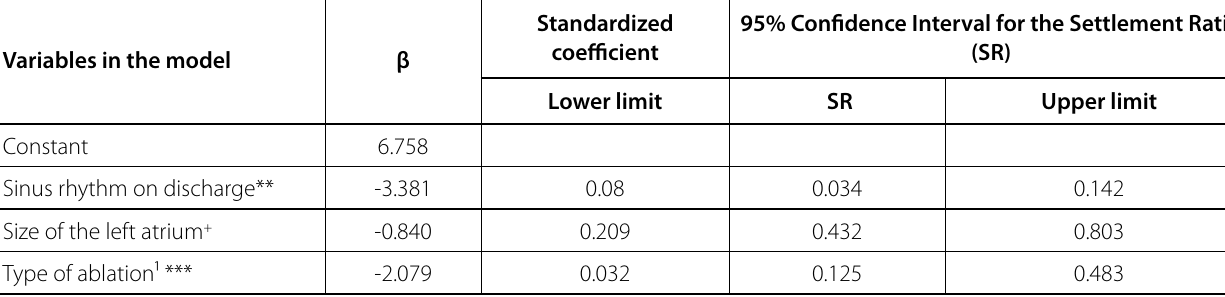
Table 3. Multivariate analysis for sinus rhythm reversion one year after